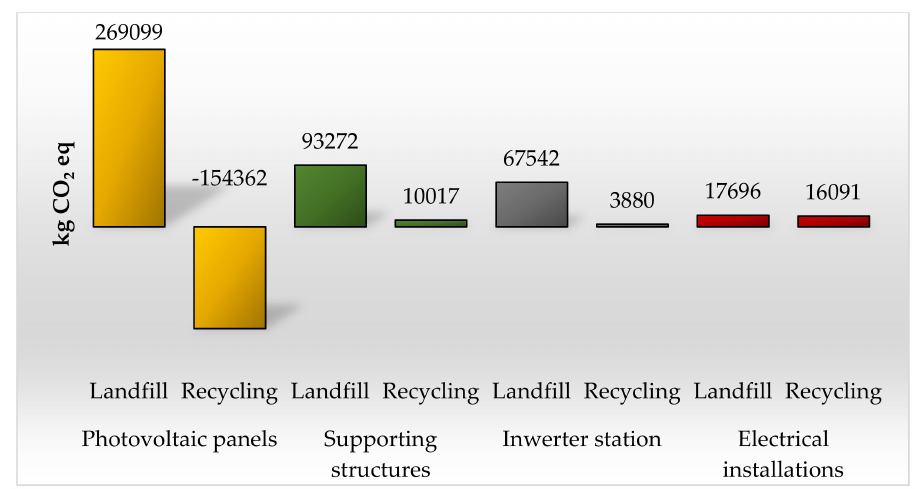
Figure 6. Results of the characterization of environmental consequences for cumulative greenhouse gas (GHG) emissions occurring in the cycle of existence of selected groups of 1 megawatt photovoltaic power plant [unit: kg CO 2 eq].